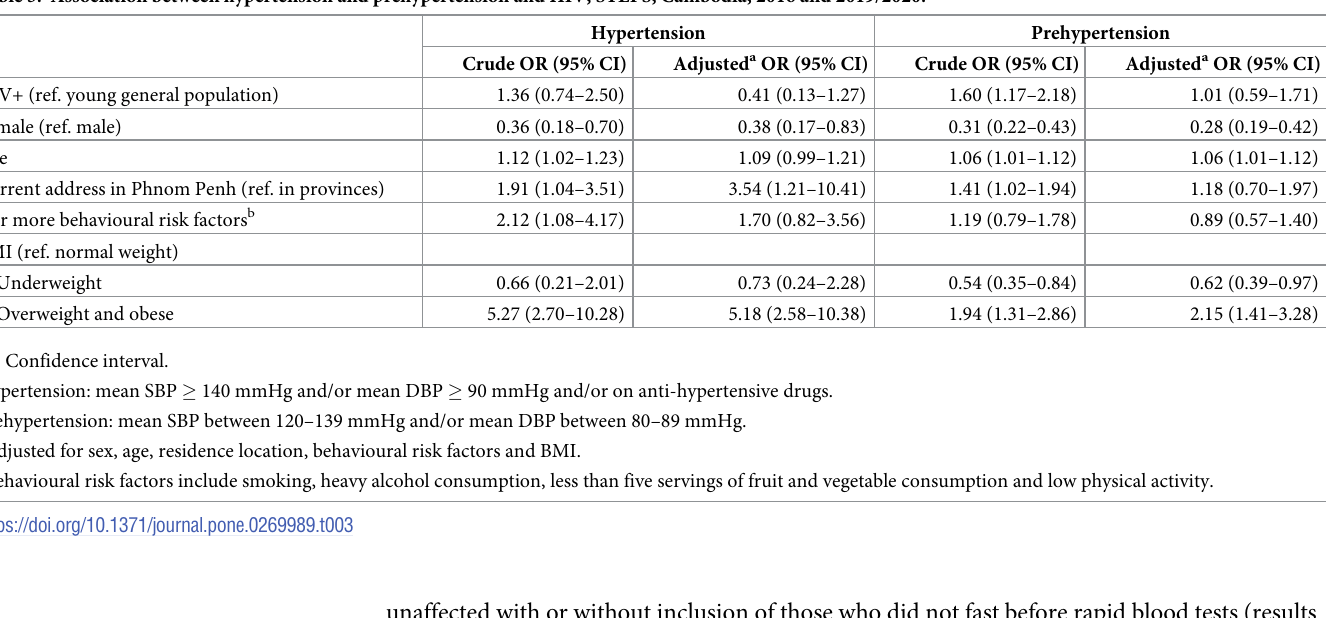
Table 3. Association between hypertension and prehypertension and HIV, STEPS, Cambodia, 2016 and 2019/2020.